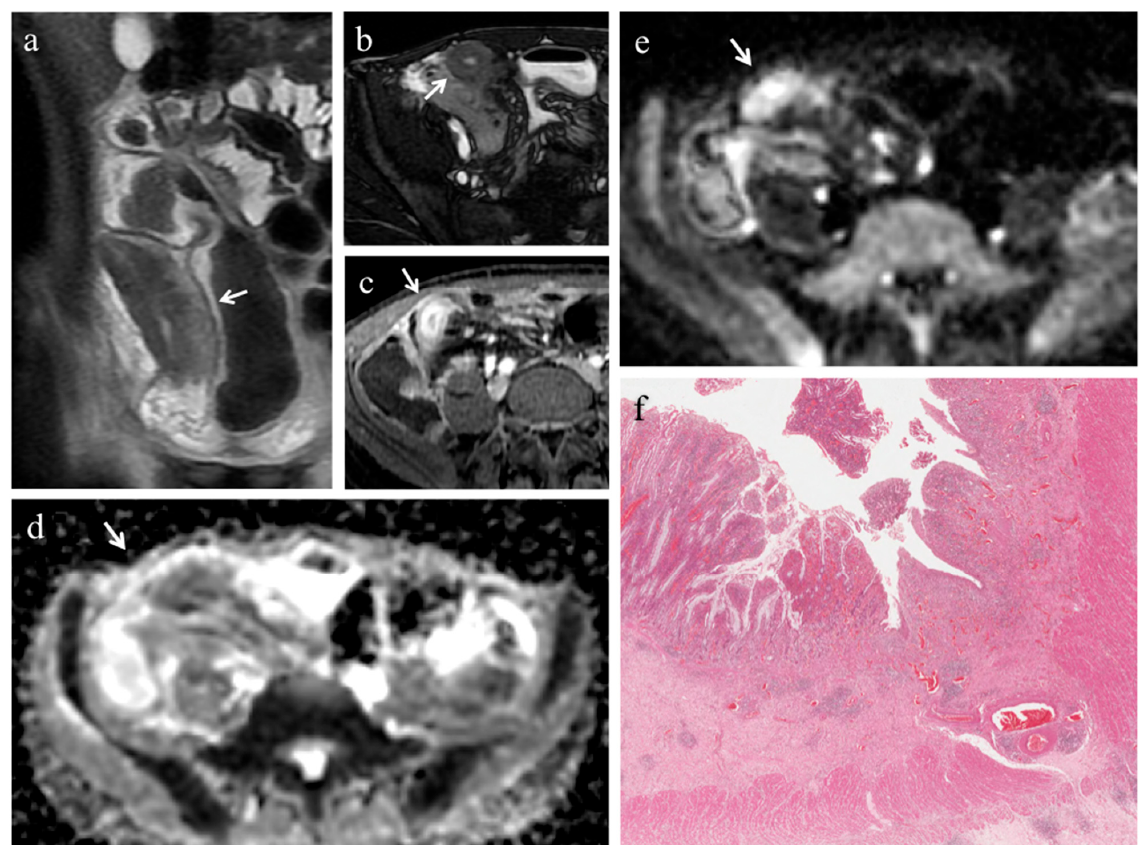
Figure 2. ( a – f ). MRE in a 19-year-old man with CD: stenosis of the terminal ileum with concomitant inflammation and fibrosis. ( a ) Coronal T2-weighted image and ( b ) axial FIESTA image show marked wall thickening of the terminal ileum with luminal narrowing (white arrows). On ( c ) axial contrast-enhanced fat-suppressed T1-weighted image, the mural thickening of the terminal ileum displays intense mucosal enhancement (white arrow). The same intestinal segment demonstrates high signal intensity on ( d ) the DW image (b = 800 s/mm 2 ) and low signal intensity on ( e ) the corresponding ADC map (white arrows) (mean ADC value 1.096 × 10 − 3 mm 2 /s), a finding consistent with restricted diffusion. ( f ) Histopathological section from the ileal stricture: hematoxylin and eosin-stained sample (H&E 10 × ). CD exhibiting mild/moderate fibrosis (FS = 1) and severe inflammation (AIS = 10): mucosal ulceration and severe inflammatory infiltration on the top; mild/moderate fibrosis, edema and inflammatory infiltration in submucosal layer on the bottom.